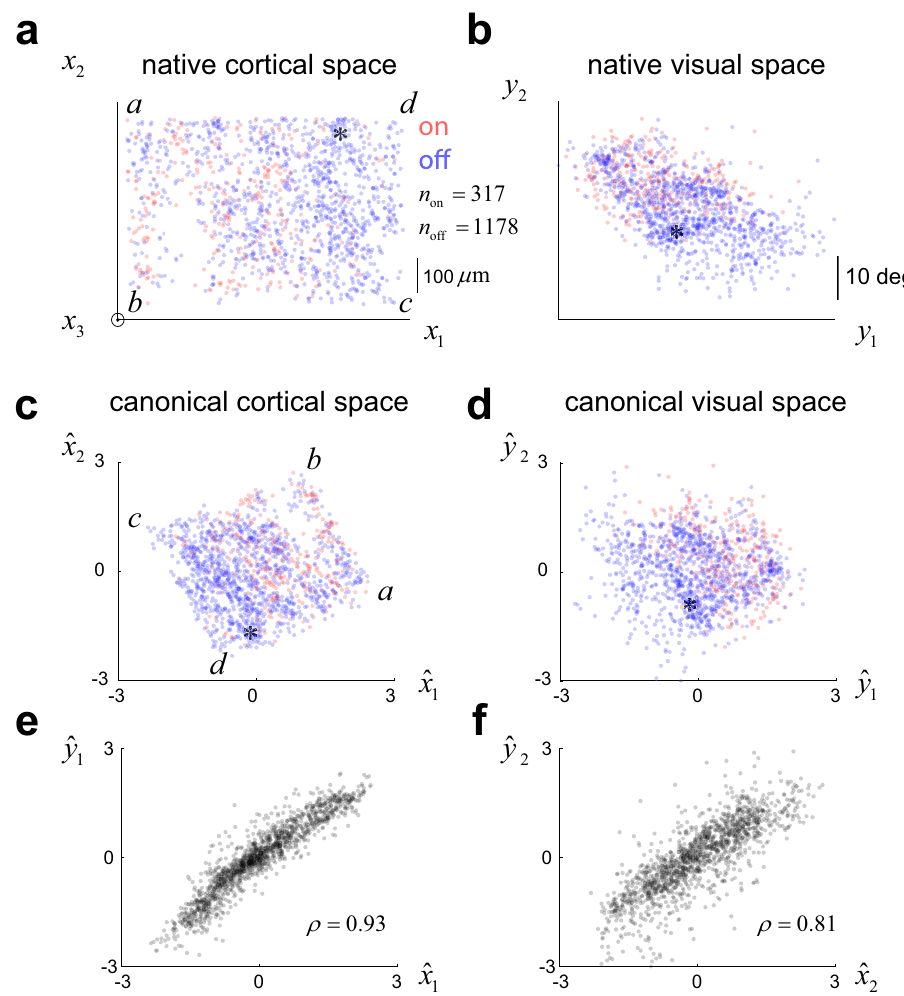
Fig. 4 Alignment of cortical and visual space via canonical correlation analysis. a , b Distribution of ON (red) and OFF (blue) neurons in the native cortical and visual spaces ( n on ¼ 317, n off ¼ 1178). Native cortical space has an x 3 component that comes out of the page, so here the data are projected into the ð x ; x Þ plane ignoring depth. c , d Same data as in a , b now represented in canonical cortical and visual spaces. Note how the locations a, b, c, d , 1 2 corresponding to the corners of the imaging plane, are mapped to canonical visual space. A location dominated by OFF cells in cortical or visual space ( a , b asterisks) will map to a location dominated by OFF cells in canonical cortical or canonical visual space ( c , d asterisks). e Correlation between the fi rst pair of canonical variables ^ x 1 and ^ y 1 and f the second pair ^ x 2 and ^ y 2 . Source data provided for all average ON and OFF signals. Let us denote the average receptive fi eld of ON cells (in native visual space) across the population by μ fi nition for μ on and adopt a corresponding de off . For simple cells, we de fi ne their receptive fi eld as the difference between their ON and OFF kernels. Finally, the average, linear receptive fi eld of the simple-cell population is denoted by μ s . The data show a strong, (cid:2) μ and μ ( p < 10 (cid:2) 10 in all signi fi cant correlation between μ on off s cases) (Fig. 6a). As predicted, the aggregate, linear receptive fi eld of simple cells matches the difference between the average of ON and OFF receptive fi elds.